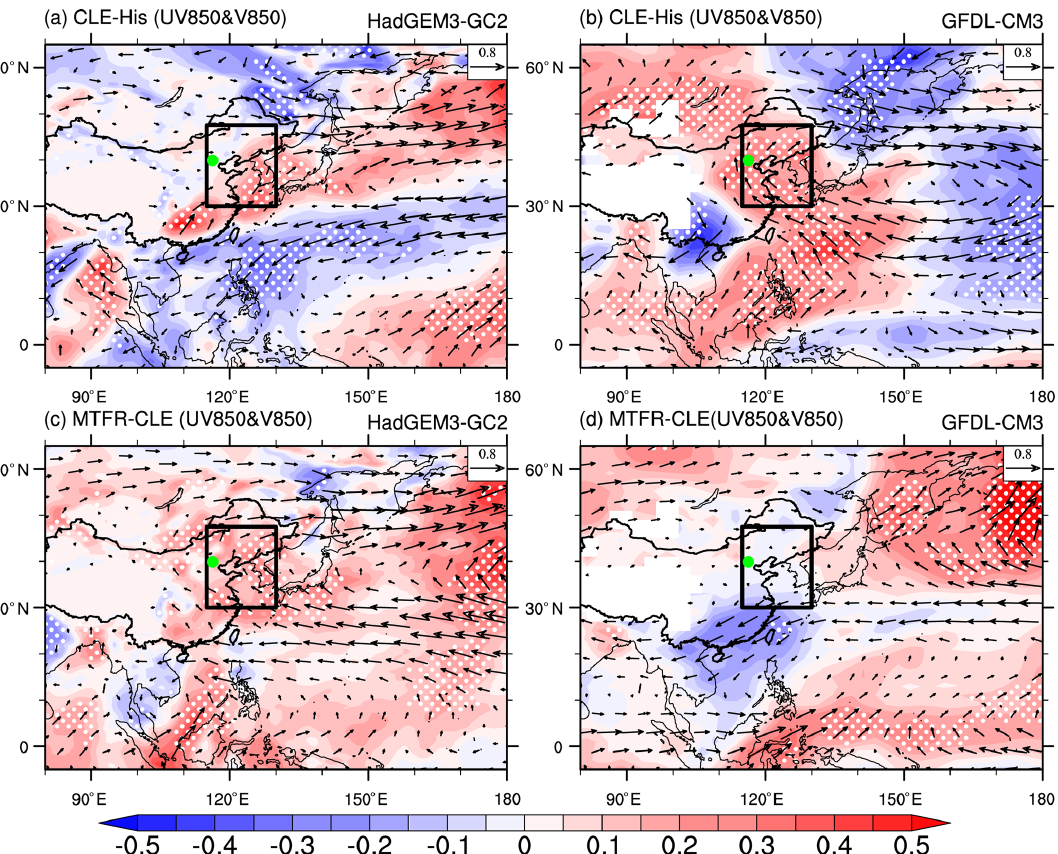
Figure 6. Spatial distribution for the difference in winter mean 850hPa winds (vector, ms − 1 ) and 850hPa meridional component (shading, ms − 1 ) (a, c) between CLE (2015–2049) and His (1984–2013) and (b, d) between MTFR (2015–2049) and CLE (2015–2049). The dotted areas denote the 850hPa meridional winds statistically significant at the 10% level using a Student’s t test. The black box indicates the region used in the calculation of